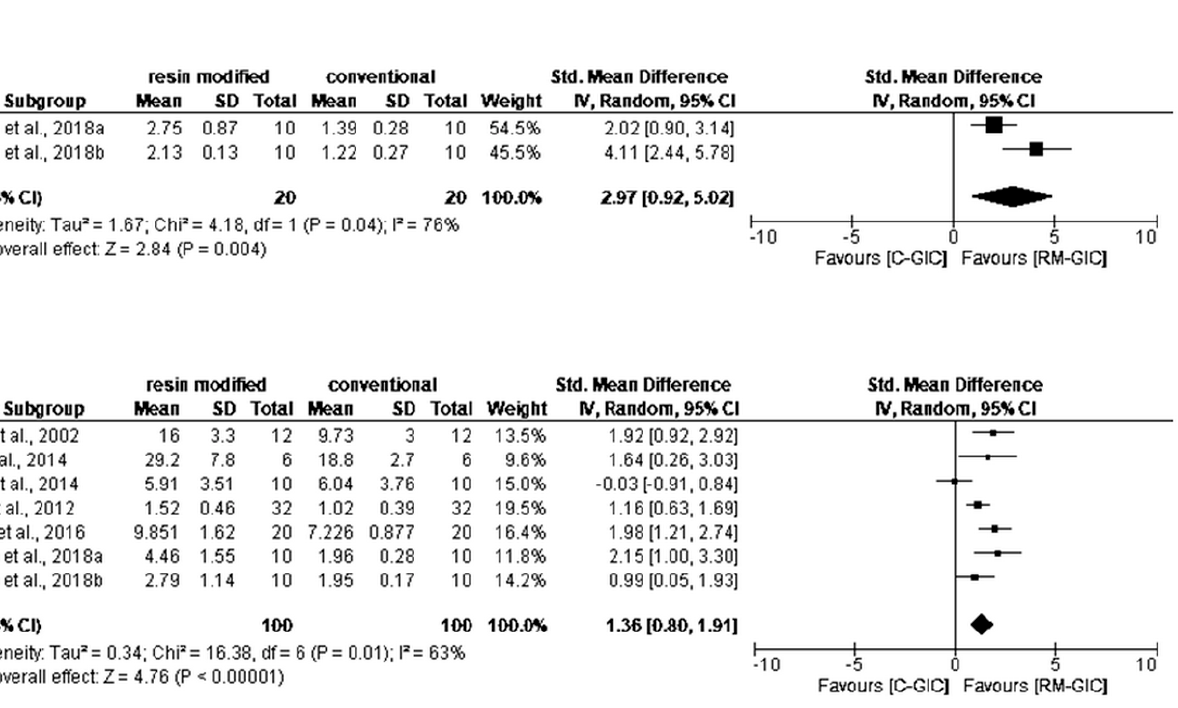
Figure 3. Forest plot for the meta-analysis of C-GIC and RM-GIC long-term bond strength in primary enamel and dentin. 4. Discussion Dental caries is one of the main public health problems in many countries [21], with early childhood caries being a global challenge [22]. Modern caries management includes various approaches, such as: no caries removal techniques (non-restorative caries control, caries arresting methods, and sealing techniques), and operative interventions, which are recommended to be minimally invasive [7]. When it comes to the operative treatment, choosing the ideal restorative material for pediatric patients is still challenging. As the use